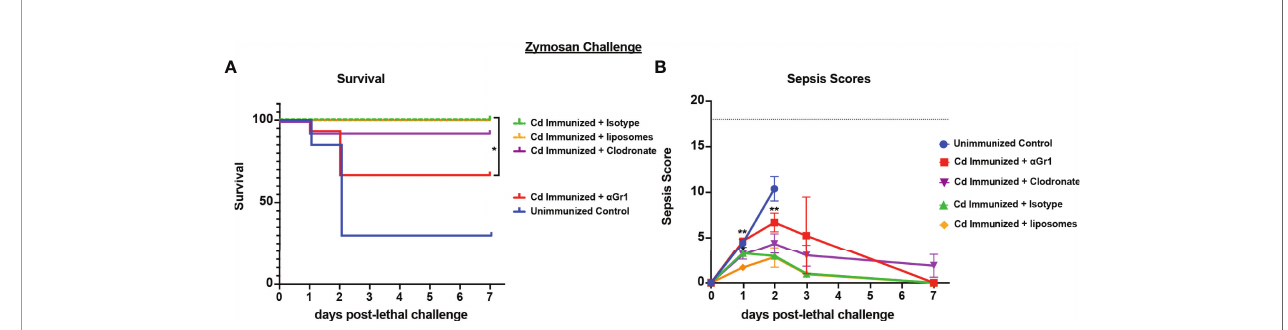
FIGURE 4 | Role of macrophages and Gr-1+ leukocytes in C. dubliniensis -induced protection in zymosan-induced sepsis. Mice (n = 10/group) were immunized by i.p. injection with 1.75x10 7 CFUs of live C. dubliniensis 14 days prior to lethal challenge. For macrophage depletion, mice were injected i.p. with liposome- encapsulated clodronate or control empty liposomes 1 day prior to lethal challenge. For Gr-1+ cell depletion, mice were injected i.p. with 200 m g anti-Gr-1 or isotype control antibody 48 h prior to and 2 h after lethal challenge. Mice were challenged with 700-1000 mg/kg zymosan and monitored for (A) survival and (B) morbidity/ sepsis scoring following lethal challenge for 10 days. Naïve (unvaccinated) mice served as the negative control. Graphs are cumulative data from 3 separate experiments. *, P<0.05; **, P<0.01; ***, P<0.001; ****, P<0.0001 [for values signi fi cantly different from those of the control, by log rank Mantel-Cox test (survival) and ANOVA followed by post hoc Student ’ s t-test (sepsis